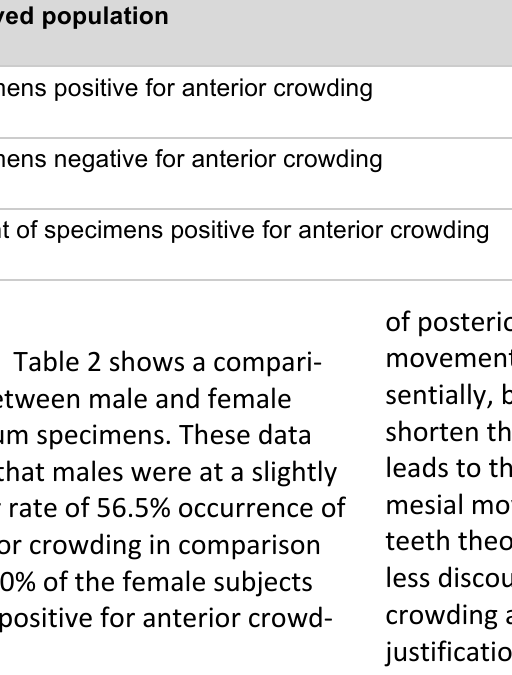
Specimens positive for an- terior crowding